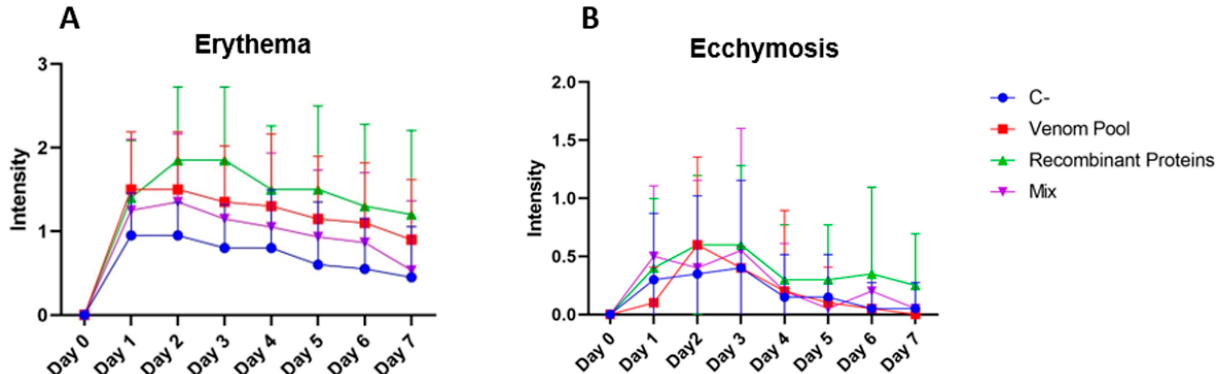
Figure 2. Monitoring of antigen injection sites of immunized rabbits. Erythema ( A ) and ecchymosis ( B ) were checked for seven days (X axis) following the immunizations with different antigens. Venom pool: pool of L. intermedia , L. laeta and L. gaucho venoms + adjuvant. Recombinant proteins: pool of mutated PLDs + adjuvant. Mix: venom pool + recombinant protein’s pool + adjuvant. C-: saline + adjuvant. The intensity of erythema and ecchymosis (Y axis) were classified from 1 to 4 according to the intensity, in which “1” represents a less intense reaction and “4” indicates a more intense sign (adapted from [35]). Each point represents the averages of intensities measured after immunizations. For erythema, results were statistically significant for Venom pool, Recombinant proteins (ANOVA, p < 0.0001 for both), and Mix (ANOVA, p = 0.0111) compared with C-